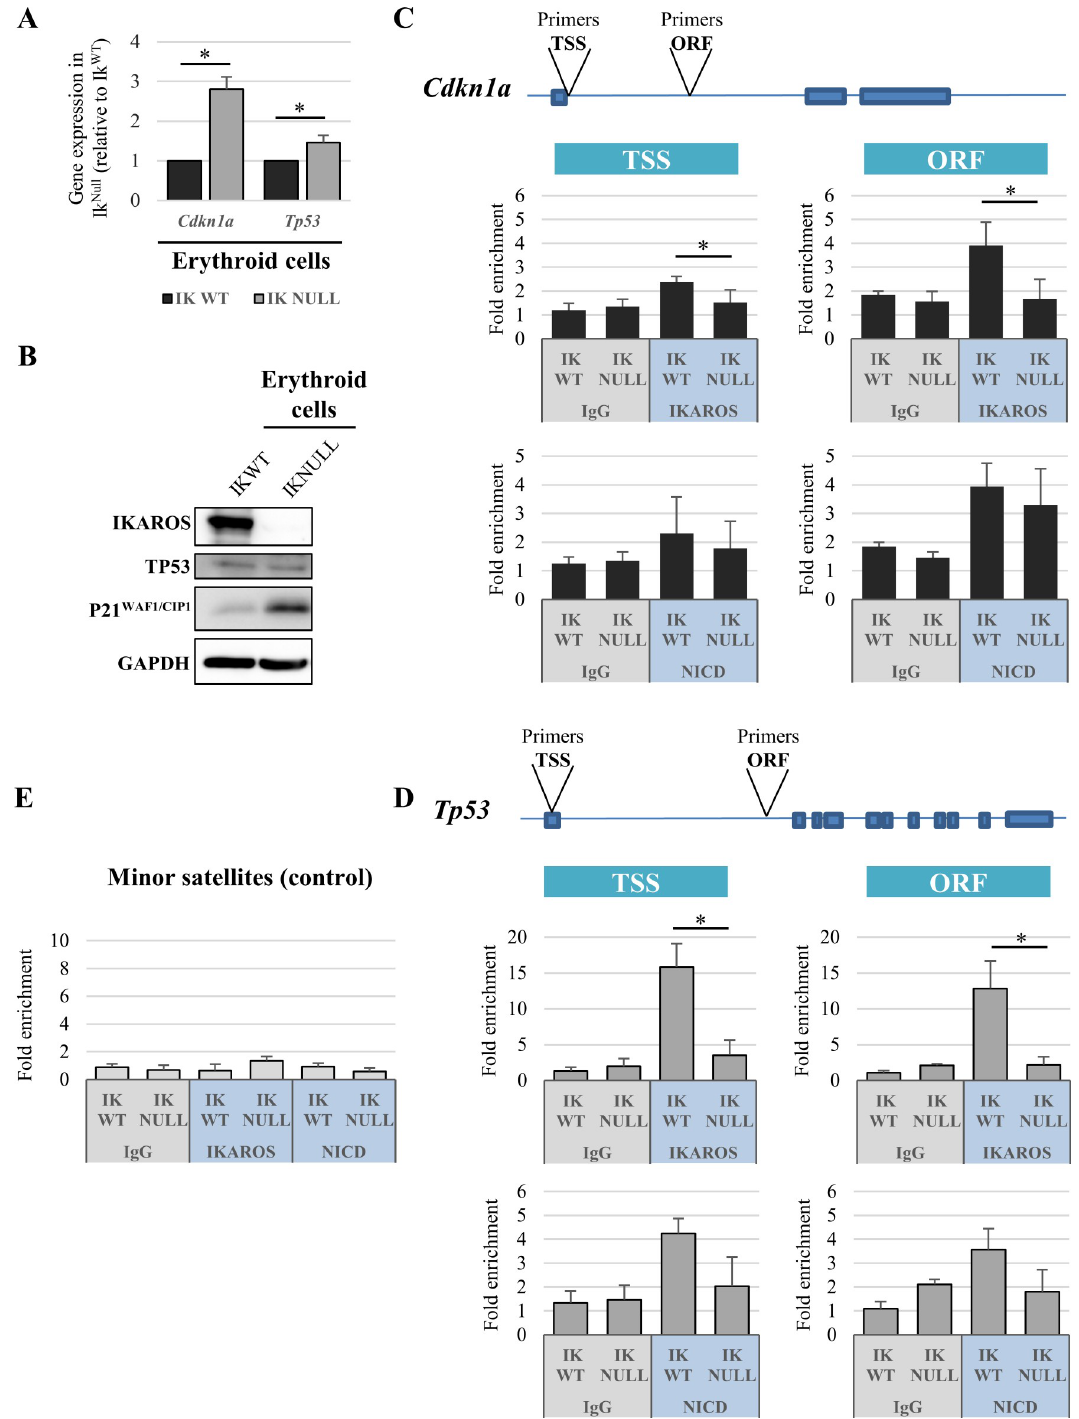
Fig 3. Characterization of Cdkn1a and Tp53 genes in Ik WT and Ik Null erythroid cells. (A) Gene expression; the relative expression levels of Cdkn1a and Tp53 genes in Ik WT or Ik Null erythroid cells were measured by qRT-PCR, calculated according to the Pfaffl equation using Hprt as internal control and normalized to Ik WT ; y axis: relative RNA enrichment levels; ratios are represented by bars and are plotted as the mean ± Standard Deviation (SD) of the measurements; data shown are the results of three independent experiments; � : p � 0.05 by Student’s t -test. (B) Western blot analysis of IKAROS, TP53, P21 WAF1/CIP1 and GAPDH (used as loading control) expression in Ik WT or Ik Null erythroid cell lysates. (C, D, E) Chromatin immunoprecipitation assays in Ik WT or Ik Null Ter119